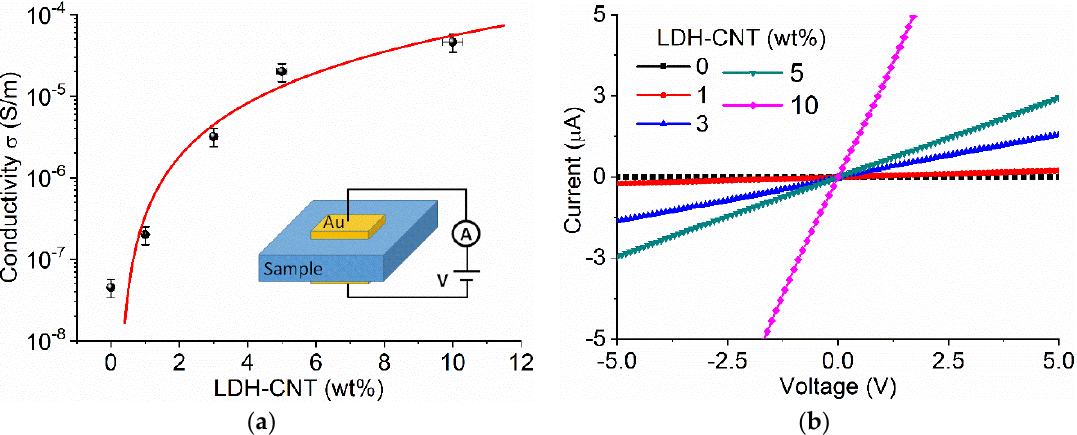
Figure 8. ( a ) Conductivity as a function of the filler loading. The inset shows the sample and measurement setup; ( b ) I-V characteristics for different filler loading.